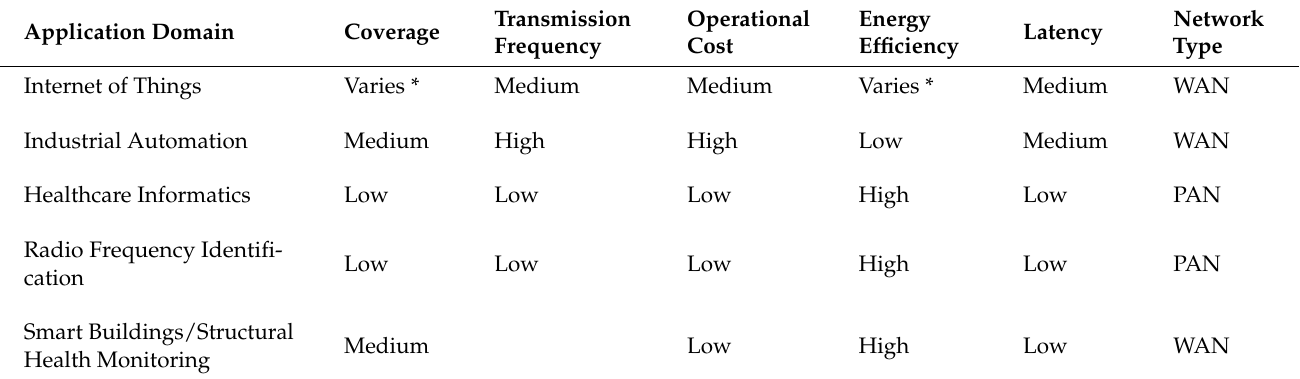
Table 4. Performance requirements for different application